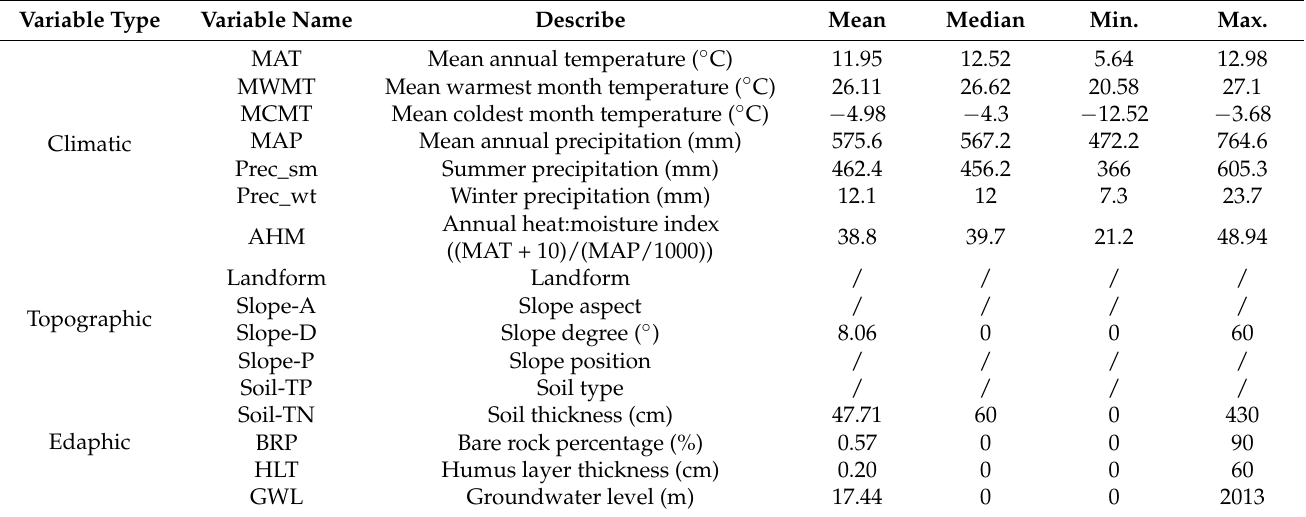
Table 2. Summary of environment variables used in this study.